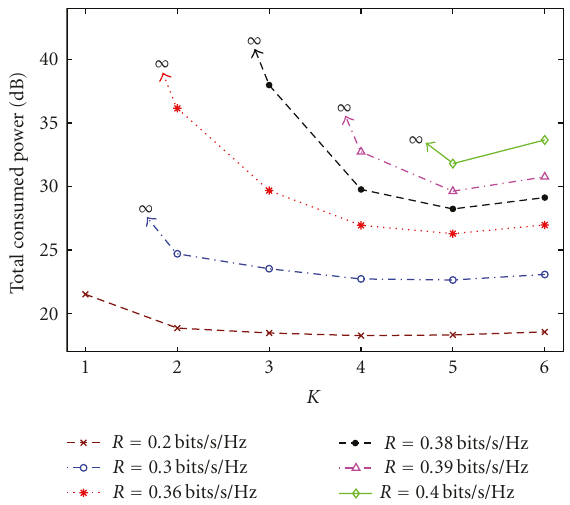
Figure 8: Total transmission power (dB) consumed by the quasireg- ular network versus K and for di ff erent uniform link data rates r l = R in bits/s/Hz, where ∞ denotes that no feasible solution was found by the DCPC algorithm following the DCLS